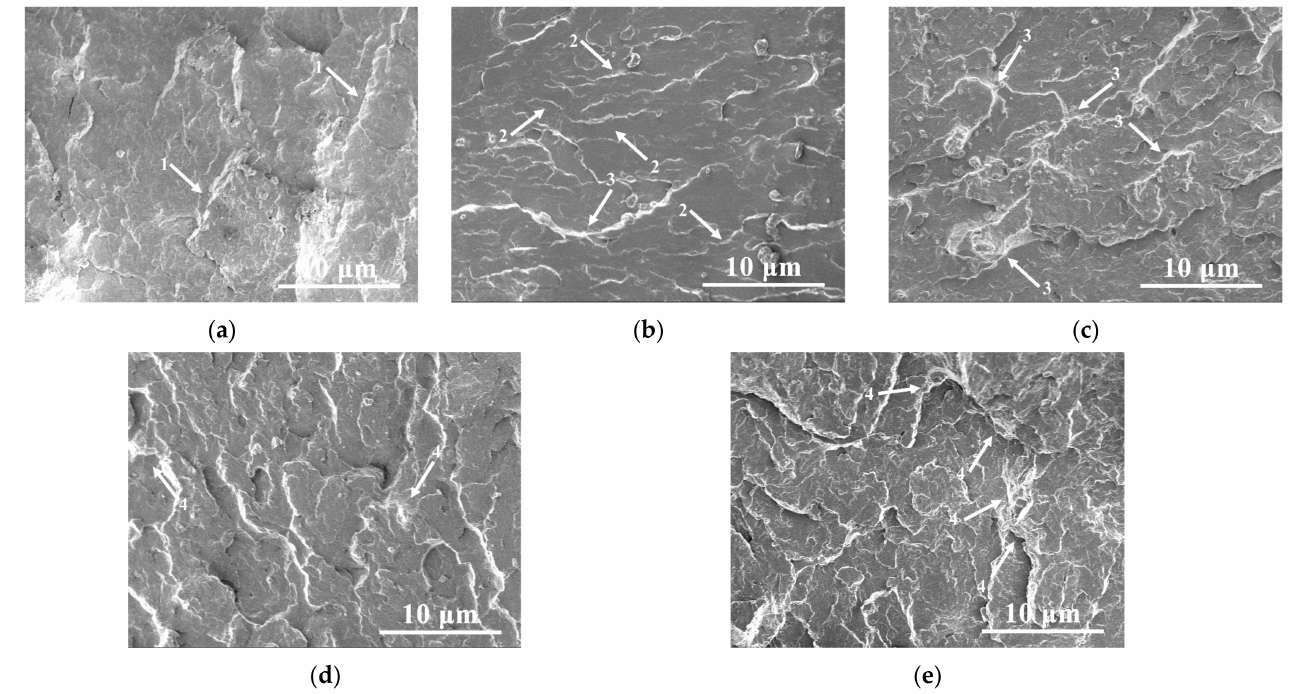
Figure 7. SEM images of the fractured surface of ( a ) PBT, ( b ) PBT-5, ( c ) PBT-10, ( d ) PBT-15, and ( e )